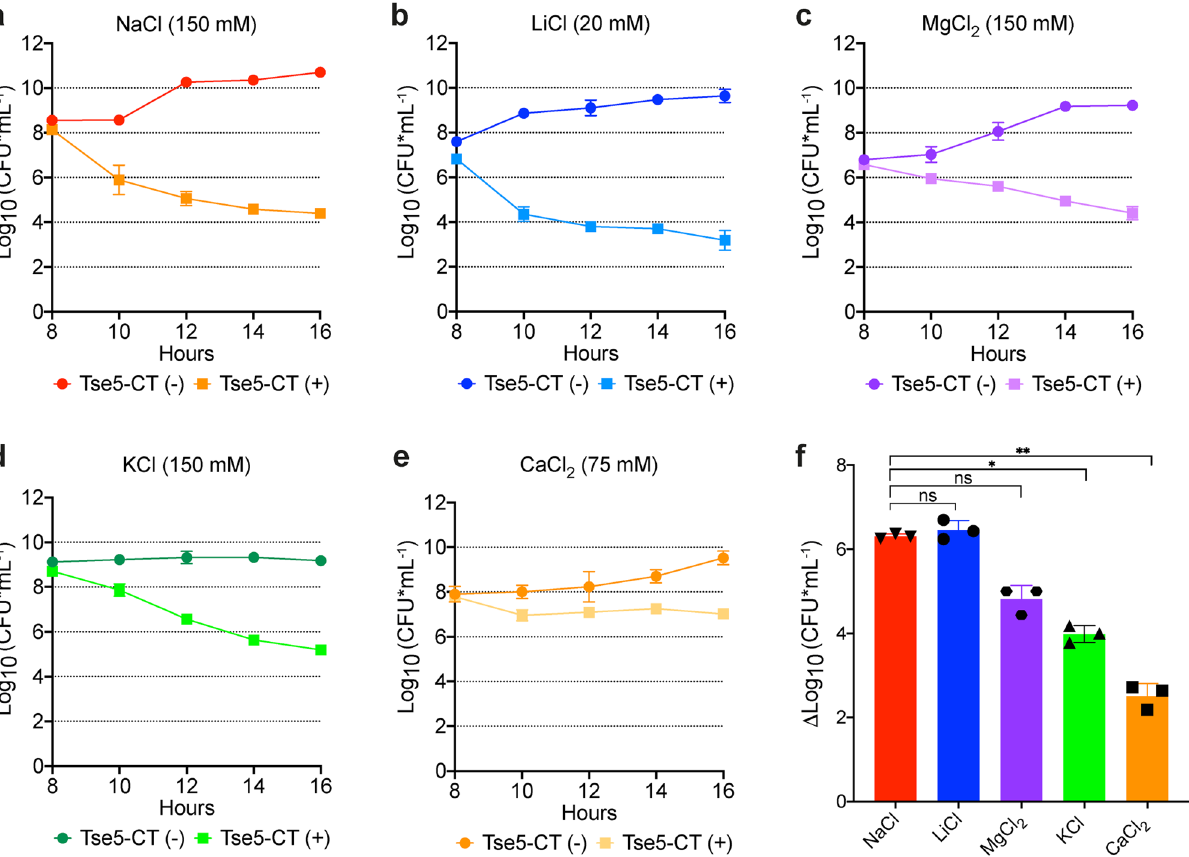
Fig. 6 Tse5-CT toxicity is accentuated in the presence of NaCl and LiCl. P. putida growth curves expressed in CFU mL − 1 with and without m-Toluic acid (TA) induction (Tse5-CT + /Tse5-CT − ). Each panel shows bacterial growth in liquid medium supplemented with a different salt: 150 mM NaCl ( a ), 20 mM LiCl ( b ), 150 mM MgCl 2 ( c ), 150 mM KCl ( d ), and 75 mM MgCl 2 ( e ). The differential growth with and without Tse5-CT expression in each liquid medium is indicated in panel ( f ). Bars show mean ± SD ( n = 3 independent experiments; ns if p > 0,05, * if p < 0.05, ** if p ≤ 0.01, one-way ANOVA (Brown – Forsythe ANOVA test) with Dunnett´s T3 multiple comparisons test). Some error bars in a – e are not visible due to overlap with symbols. Source data are provided as a Source Data fi